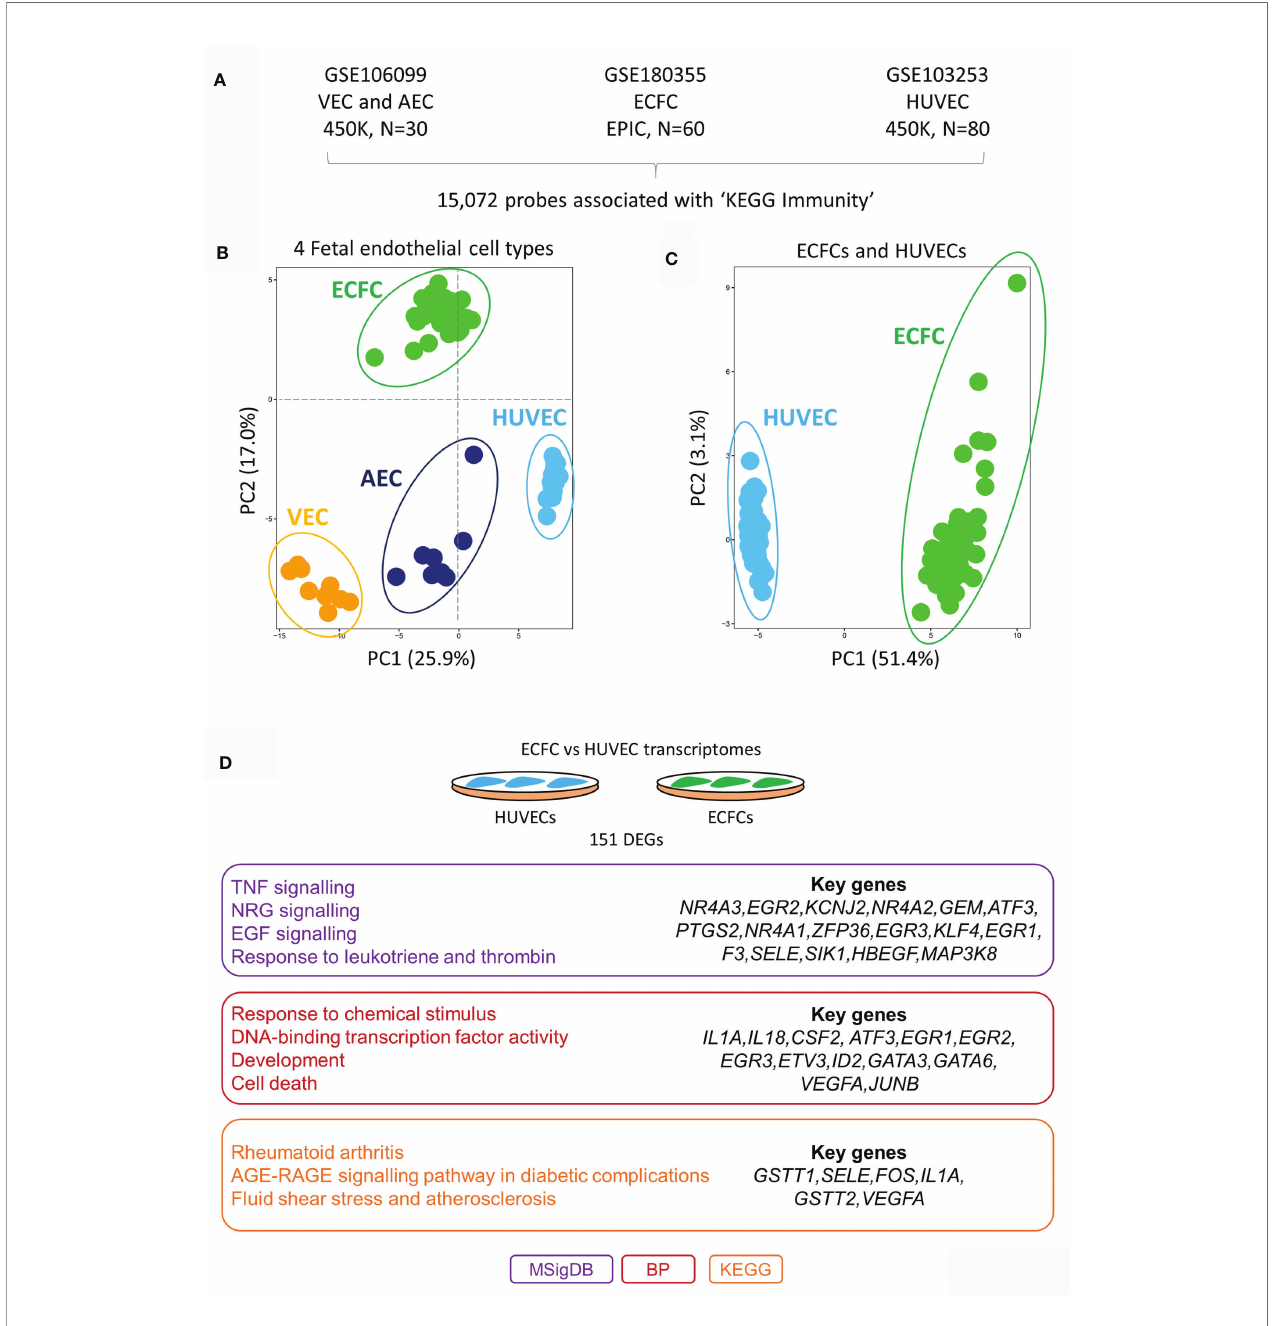
FIGURE 1 | DNA methylation and transcriptomic pro fi les of immunity-related genes in different placental endothelial sub-types. (A) Immunity-related probes were extracted from publicly available In fi nium HumaMethylation datasets for VEC (450K platform), AEC (450K platform), ECFC (EPIC platform) and HUVECs (450K platform). (B) PCA plot of immune-related probes at rest. HUVECs are separated via PC1 and ECFCs via PC2 from the other fetal endothelial cell types. (C) PCA plot of immune- related genes at rest in ECFCs and HUVECs. (D) Differentially expressed genes between ECFCs and HUVECs at baseline. Gene ontology terms associated with the differentially expressed genes. MSigDB, GSEA Molecular Signatures Database; BP, Gene Ontology Biological Process; KEGG, Kyoto Encyclopedia of Genes and